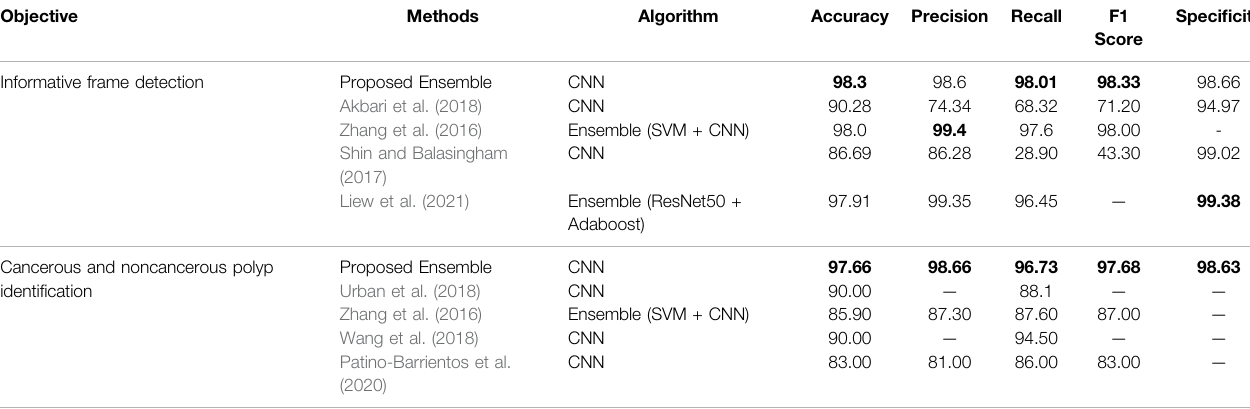
*Bold values indicate the best performance.